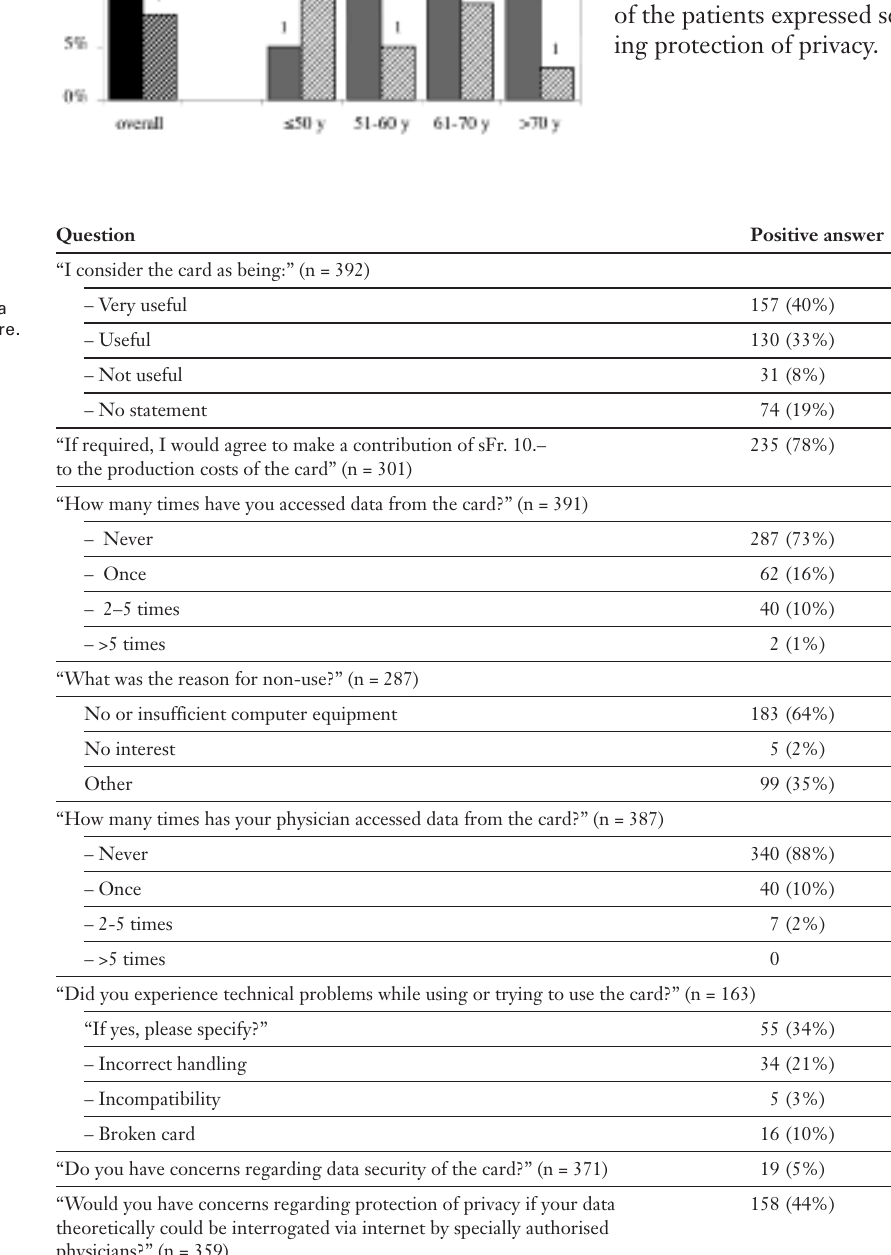
Proportion of pa- tients affirming that their physicians ac- cessed data from the CardioCard ® : responses stratified by patients’ age and gender (number of patients given at the top of each